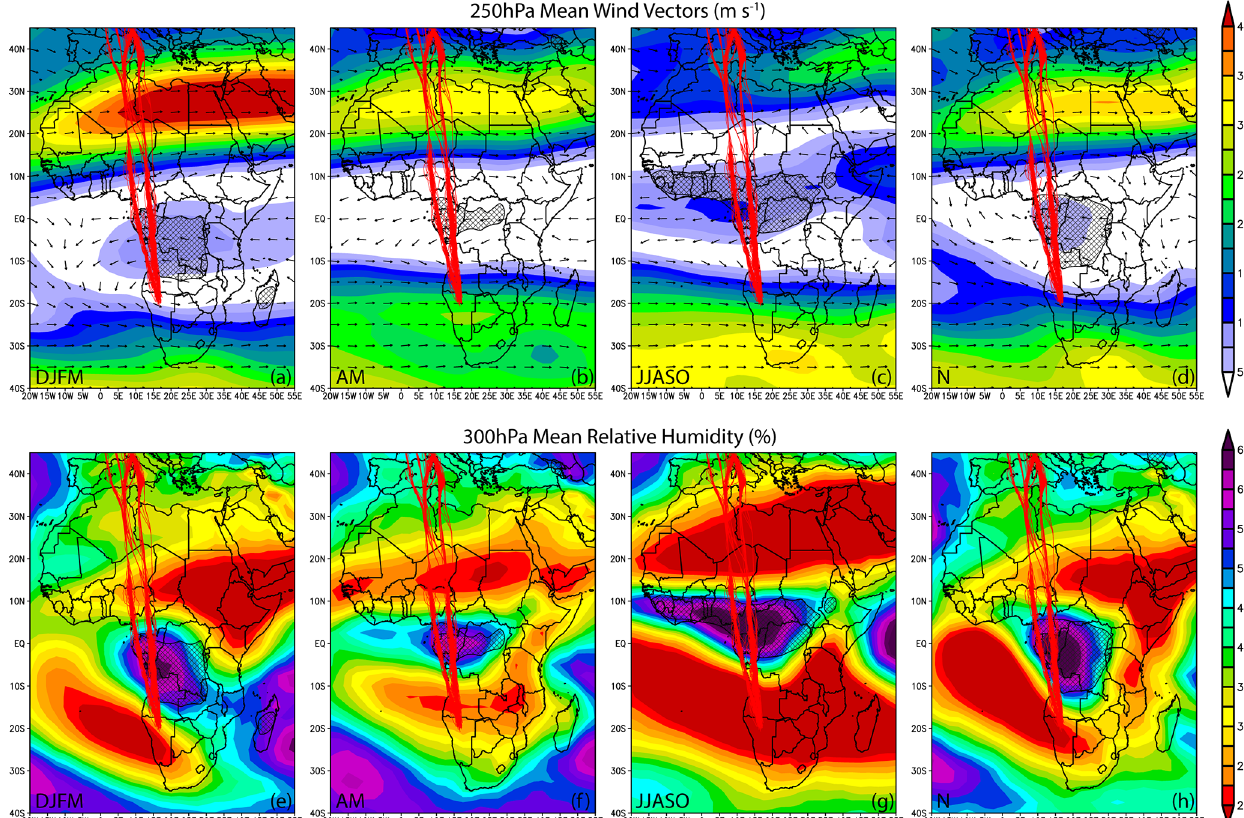
Figure 3. Seasonal mean wind circulation at 250hPa (a–d) and mean relative humidity at 300hPa (e–h) above Africa between 2006 and 2013 from NCEP reanalysis. Red lines represent the IAGOS flight trajectories. Black hatched contours represent areas with OLR < 220Wm − 2